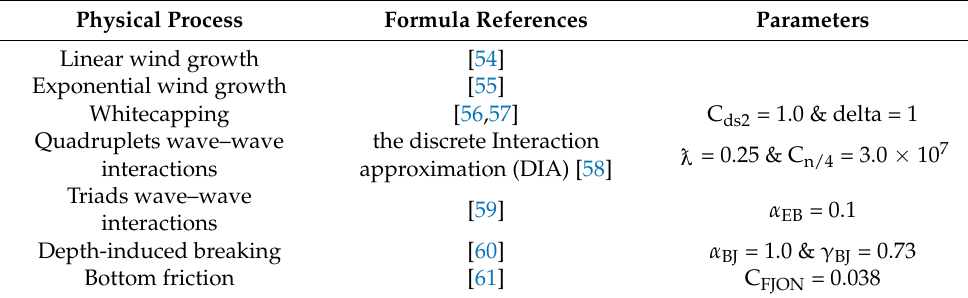
Table 1. The calibrated physical processes’ settings of SWAN model used for the development of the wave hindcast database